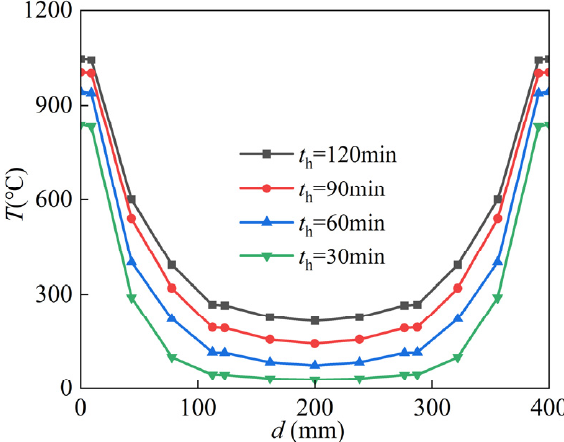
Figure 6. Temperature–depth curves.